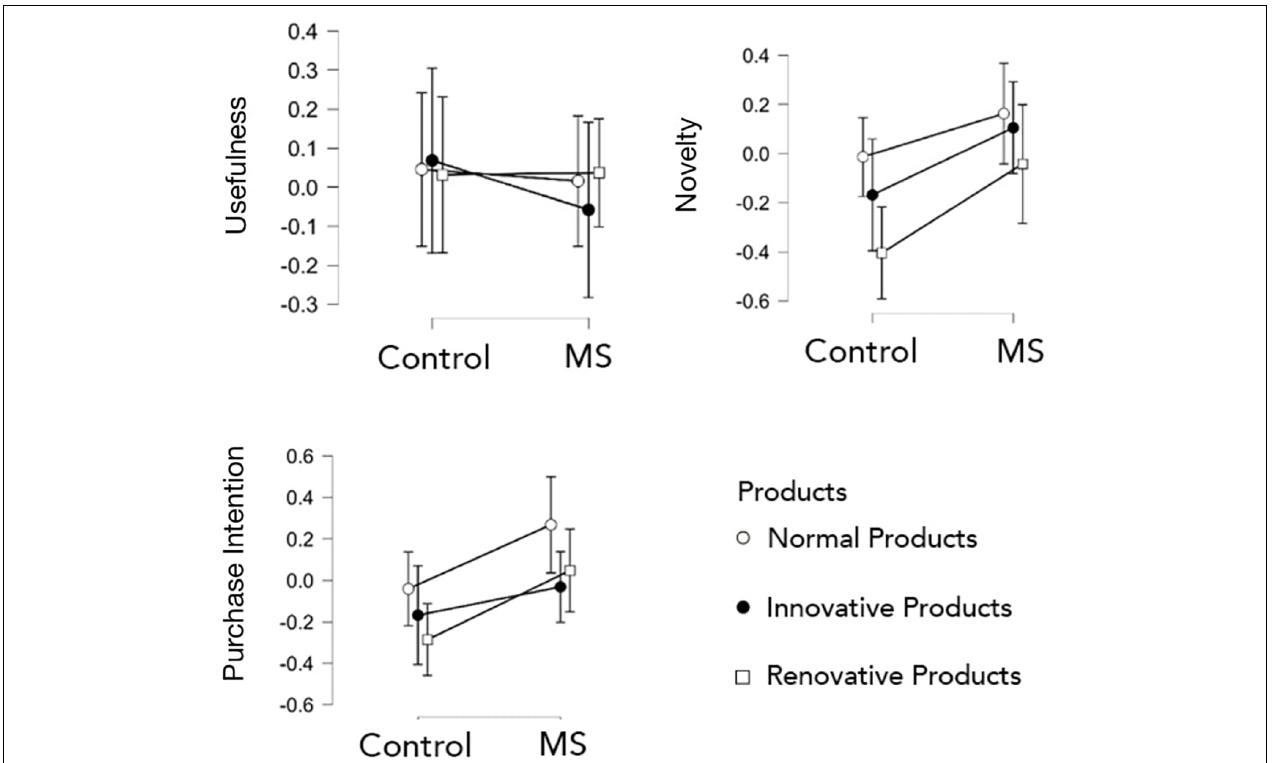
FIGURE 1 | The ANONA analysis results of Experiment